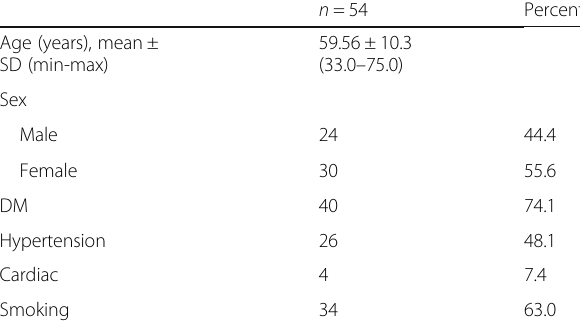
Table 1 Demographic and history of the studied